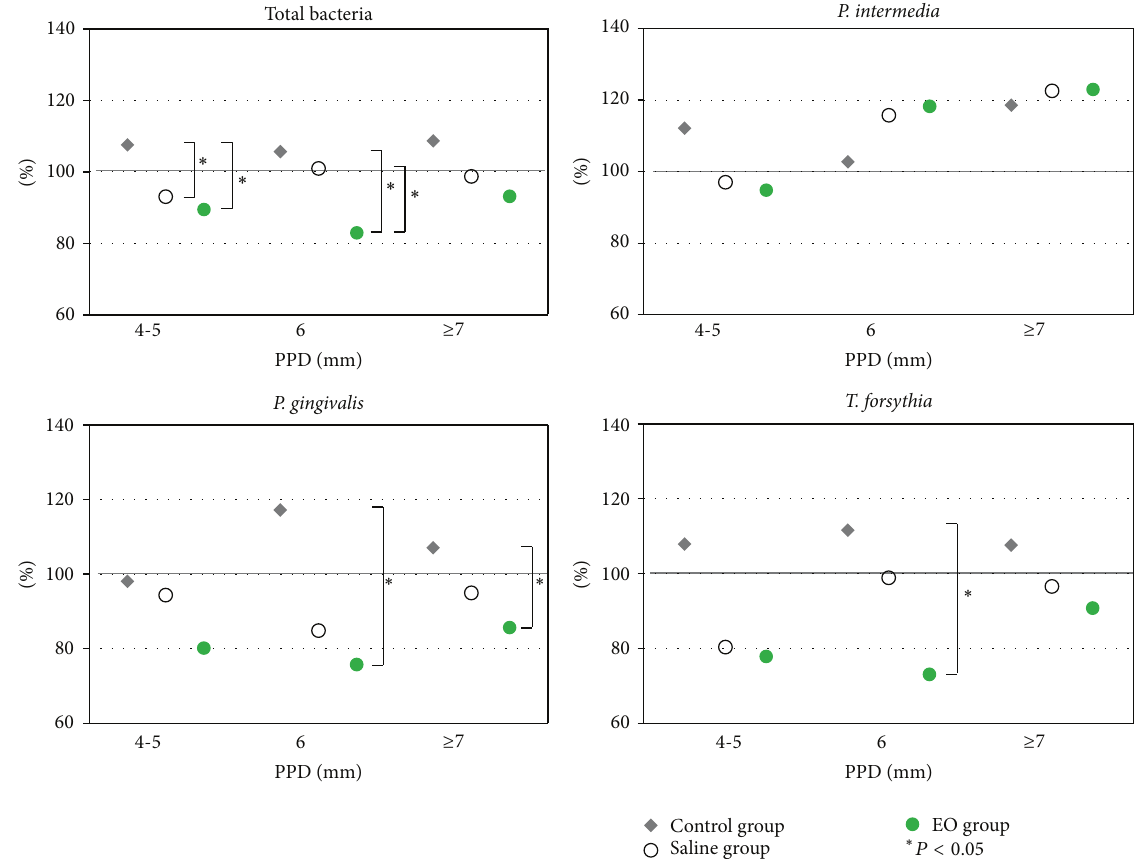
Figure 1: Intergroup comparisons of the change ratio of subgingival bacterial counts. Intergroup comparisons of percentage changes ratio of subgingival bacterial counts after 7 days relative to the baseline value for total bacteria and selected periodontitis-related bacteria across the 3 categories of periodontal pocket depth. ∗ indicates statistical significance at P < 0.05.